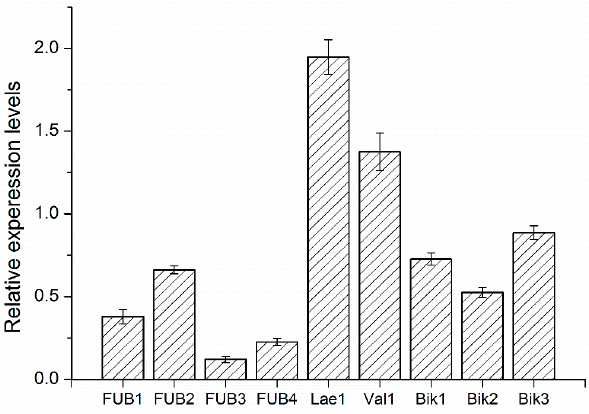
Figure 6. Gene expression level of synthesis of fusaric acid ( FUB1 , FUB2 , FUB3 and FUB4 ) and bikaverin ( Bike1 , Bike2 and Bike3 ), and components of a velvet-like complex (Lae1 and Vel1 ) relative to without treatment cuminic acid. Values are the means ± standard error (SE) of three repeated experiments. Expressions of FUB3 , FUB4 and Bike2 were about 0.88, 0.77 and 0.46 fold lower relative to the internal control. However, genes of components of a velvet-like complex ( Lae1 and Vel1 ) exhibited significantly increased expression (1.95 and 1.37-fold).